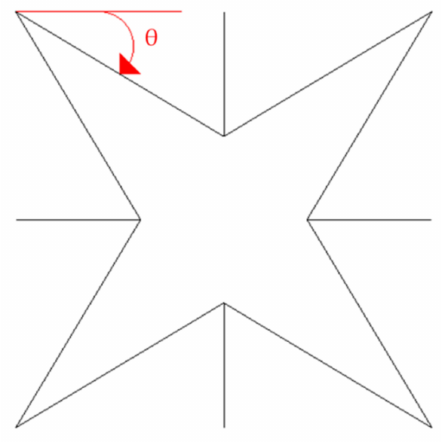
Figure 13. The auxetic angle θ . Adapted from